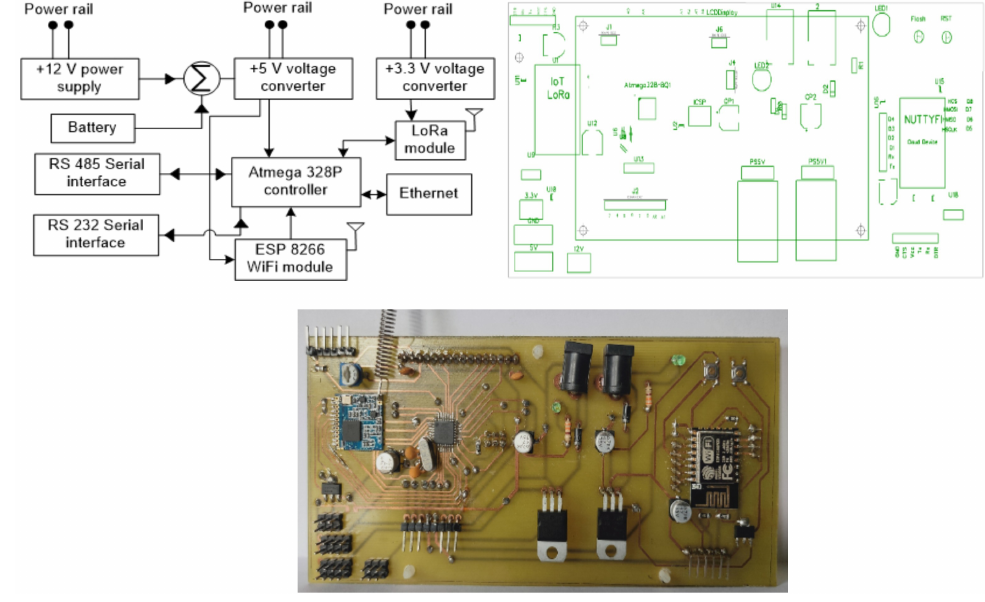
Figure 3. LoRa-based gateway.